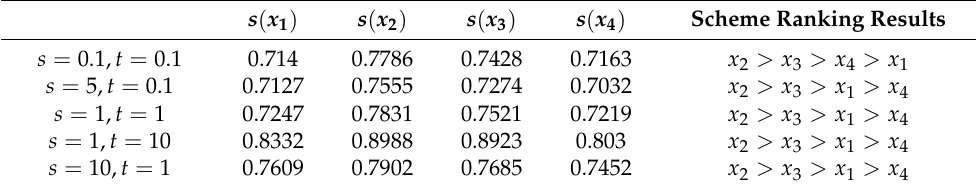
Table 5. Scheme ranking results for different values of s and t